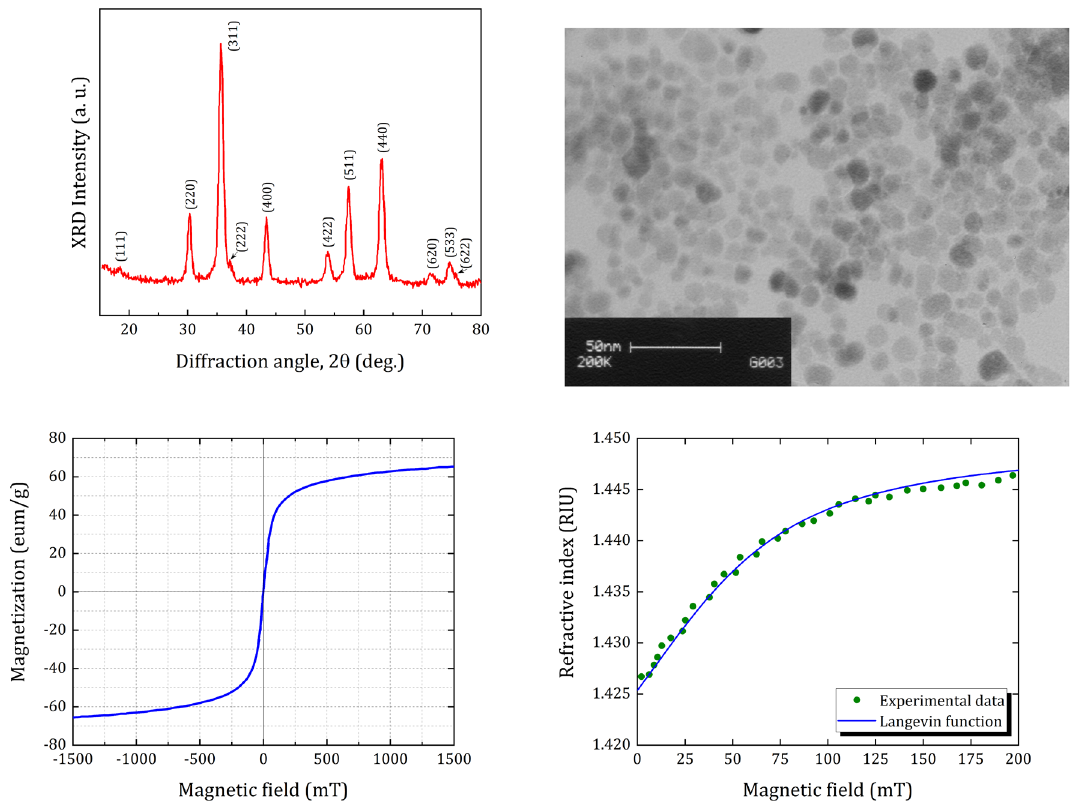
Figure 2. ( a ) X-ray diffraction pattern and ( b ) TEM image for as-synthesized Fe 3 O 4 magnetic nanoparticles. ( c ) Room-temperature magnetization curve and ( d ) Refractive index of ferrofluid versus magnetic field